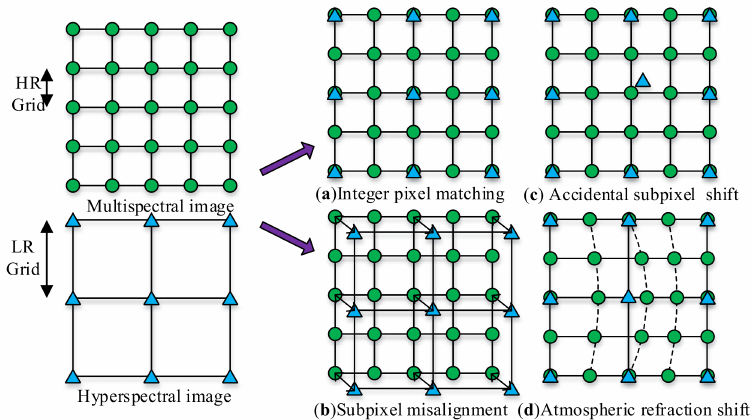
Figure 2. Schematic diagram of integer pixel matching and subpixel shift in multispectral and hyperspectral image